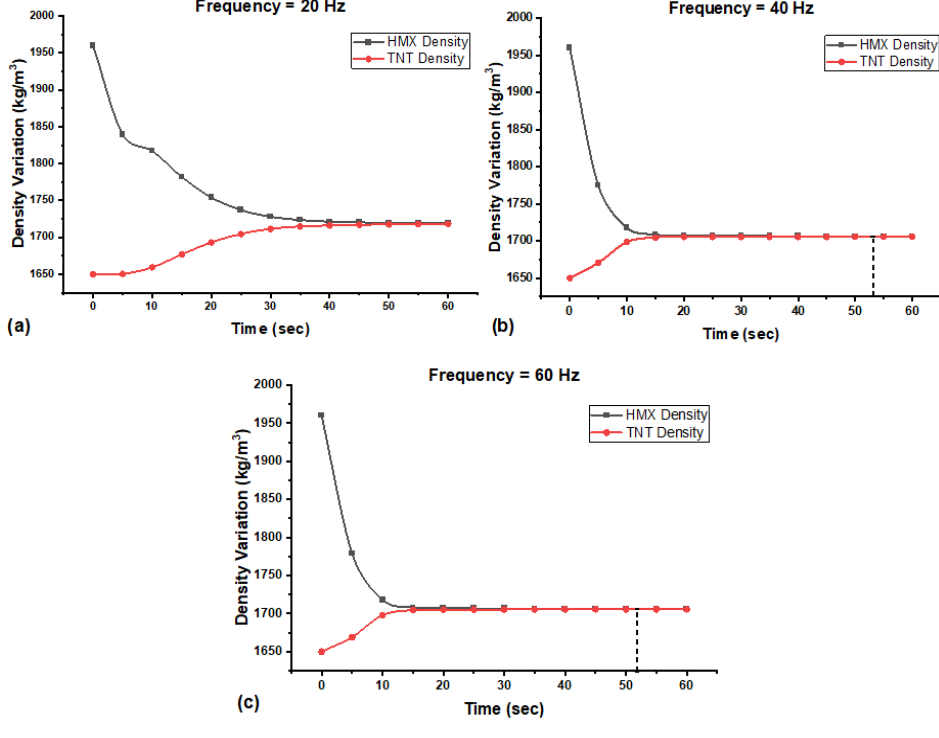
Figure 12. Plots of Density Variation from ( a – c ) over different values of frequency.